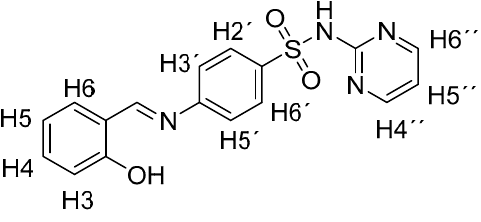
Figure 3. Numbering of H atoms in NMR spectra.